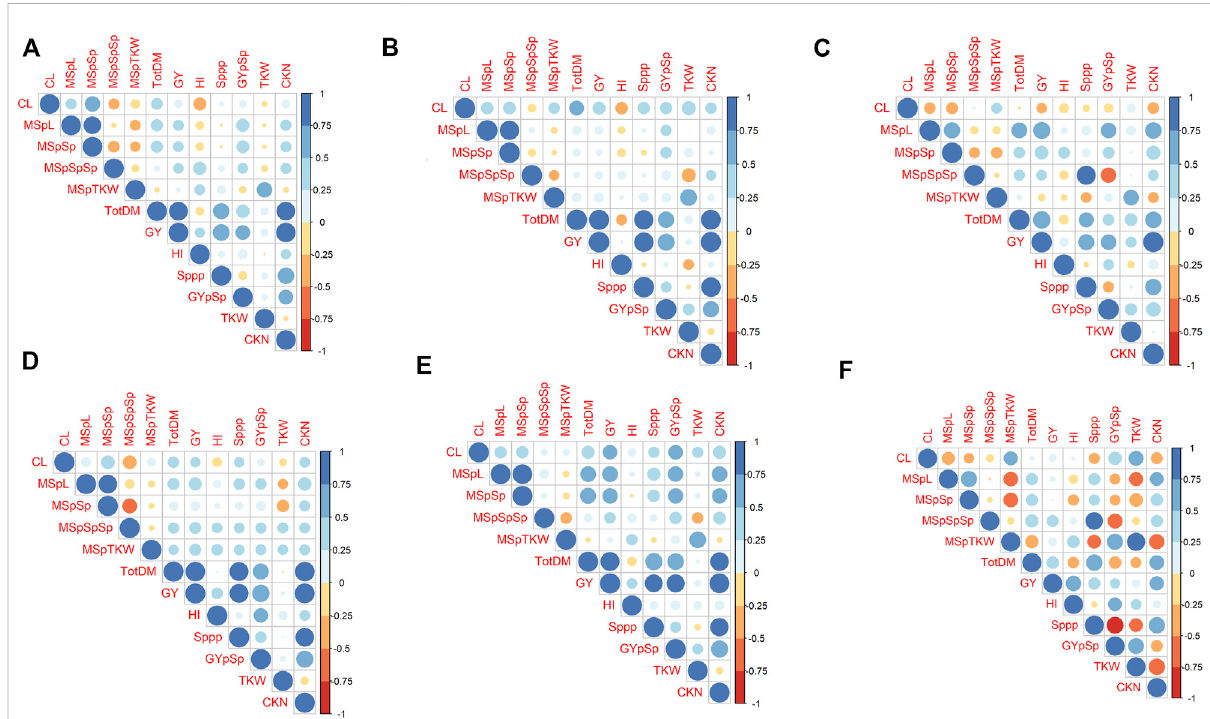
FIGURE 3 Correlation analysis of phenotypic data, obtained under water-limited (WL) and well-watered conditions (WW) in 2017, 2018 and 2019. Results for 2017, 2018 and 2019 were illustrated from the left to the right. The subplots (A – C) illustrate results that were obtained under WW conditions, (D – F) illustrateresultsforWL-conditions.CKN=Calculatedkernelnumber,CL=CulmLength,GY=Grainyield,HI=Harvestindex,TKW=Thousand kernel weight, TotDM = Total Dry Matter, MSpL = Main Spike Length, MSpTKW = Main Spike thousand kernel weight, MSpSp = Main Spike Spikelets, MSpSpSp = Seeds per spikelet (of the main spike), Sppp = Spikelets per